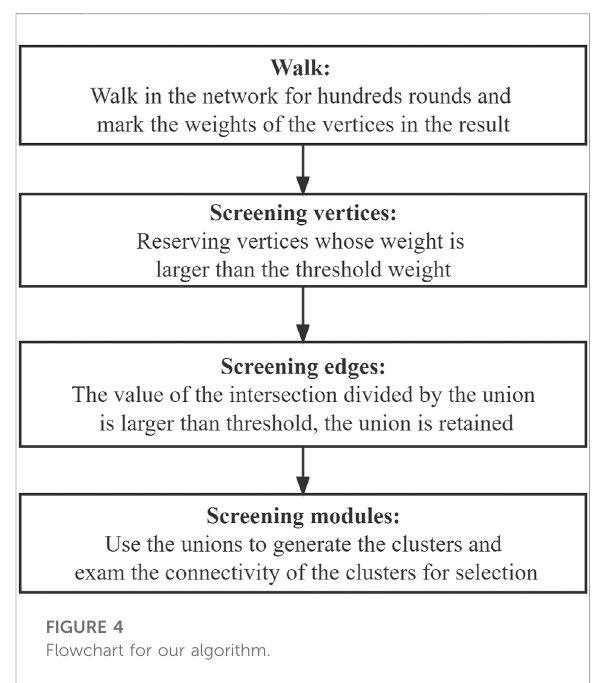
FIGURE 4 Flowchart for our